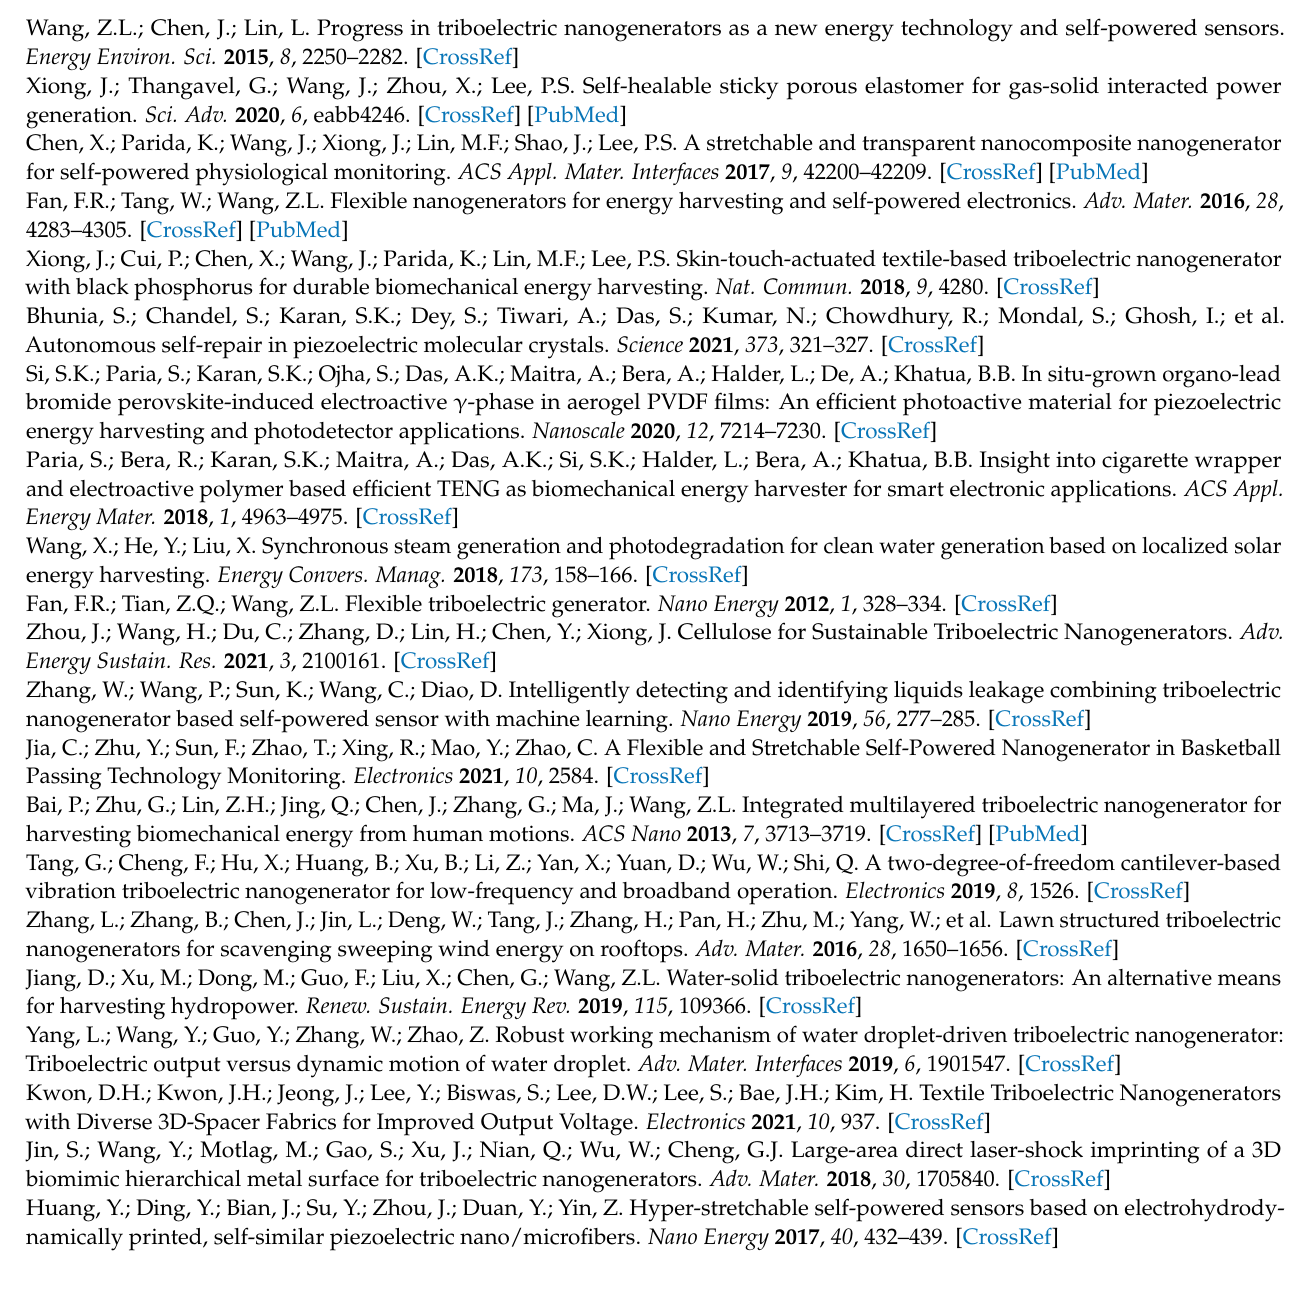
the fabricated TENG device; Figure S3: (a) Static contact angle and (b) sliding angle of the flat PDMS film; Figure S4: Contact angles of the hierarchical structures with a secondary micropillar center distance of 6 µ m; Figure S5: Noise level of the water-TENG device for output voltage